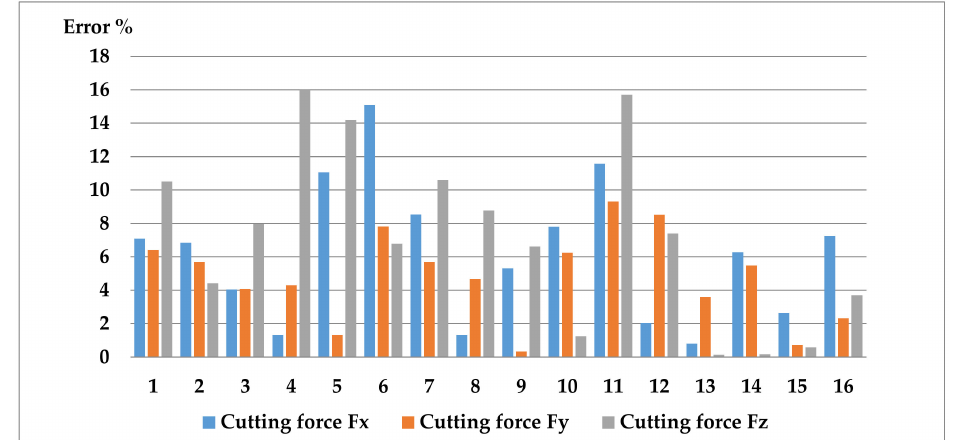
Figure 14. Cutting force error percentage comparison between experimental and RSM predicted